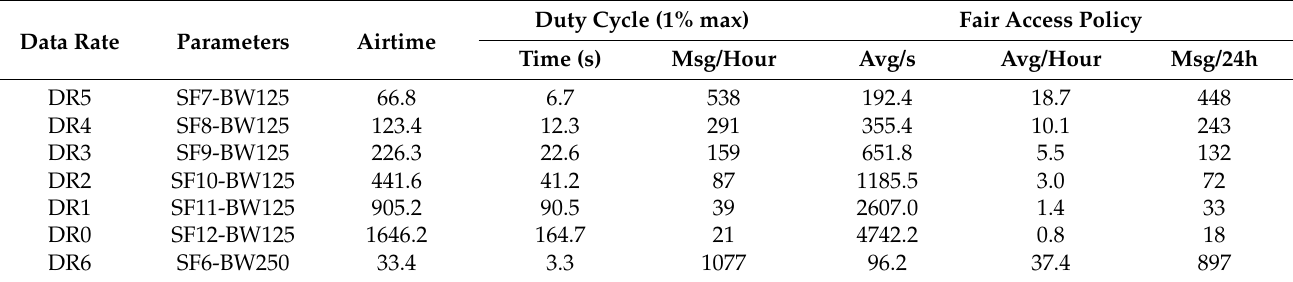
Table 11. Airtime parameters for the LoRaWAN in EU868